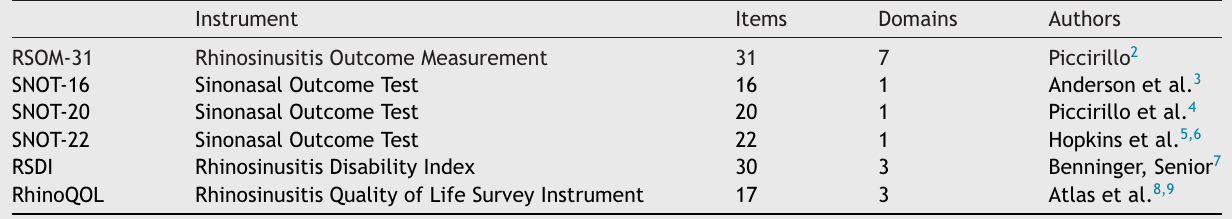
Table 1 Questionnaires for assessment of quality of life in rhinosinusitis.